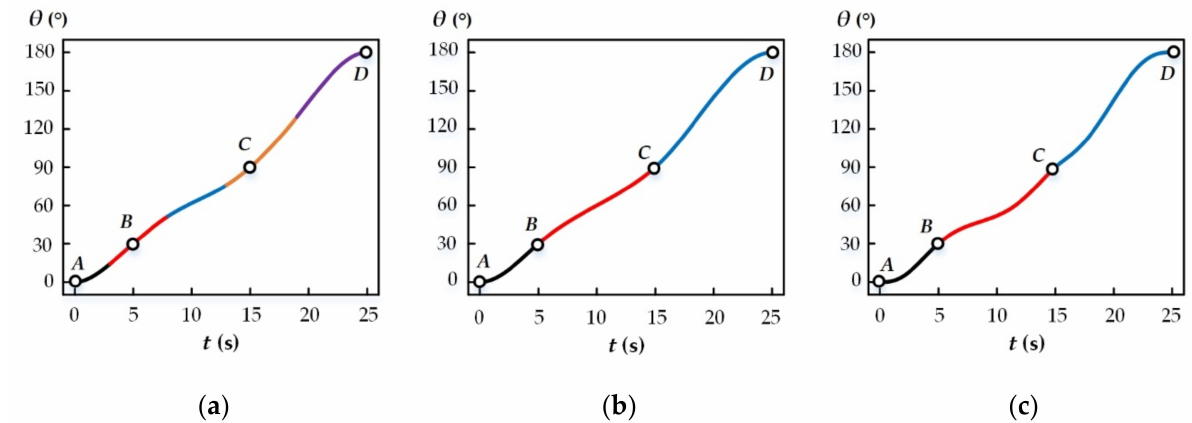
Figure 13. Angular displacement comparison: ( a ) Proposed methodology planning; ( b ) Cubic polynomial planning; ( c ) Quintic polynomial planning.